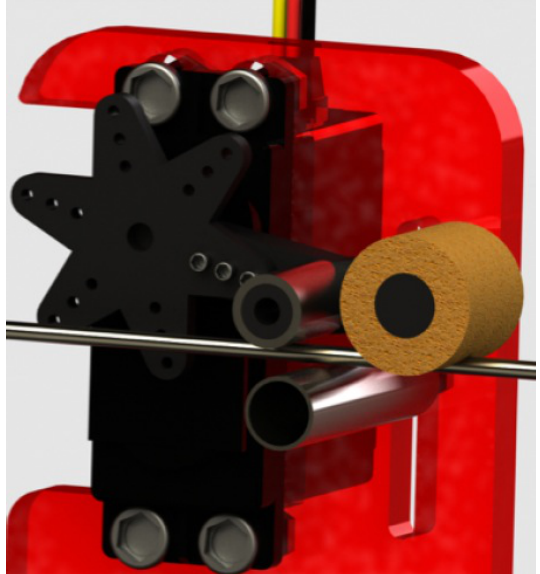
Fig. 13. Group III’s clamping and vibration minimising